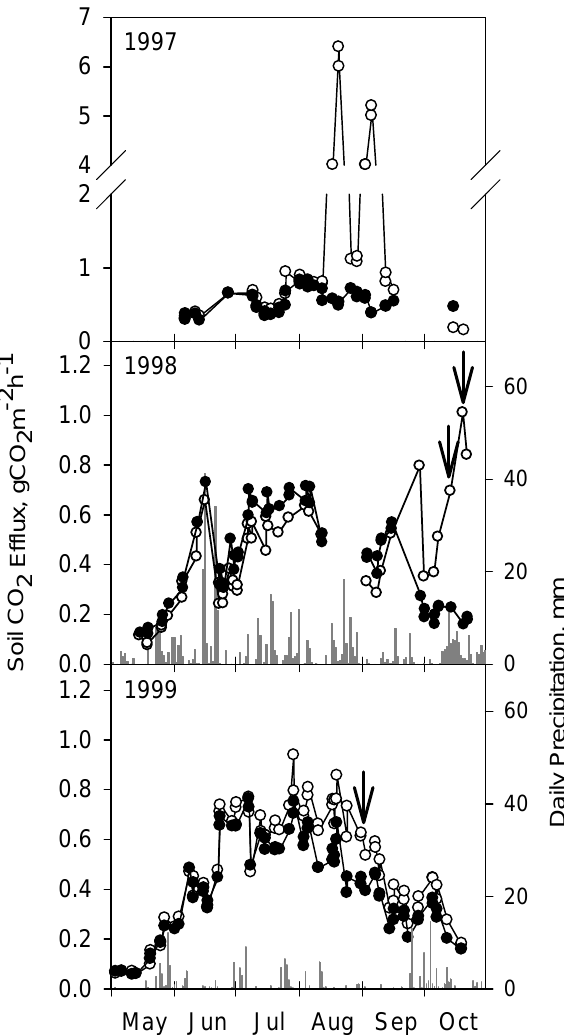
Fig. 2. Three examples of sudden increases in the level of soil CO 2 efflux from a point. Plot averages of 9–10 points are represented by black circles and efflux from an individual point by open circles, one or two measurements per measuring day. Daily precipitation is depicted with grey bars. Arrows point at occasions when a fungal fruit body was found in a collar and removed.